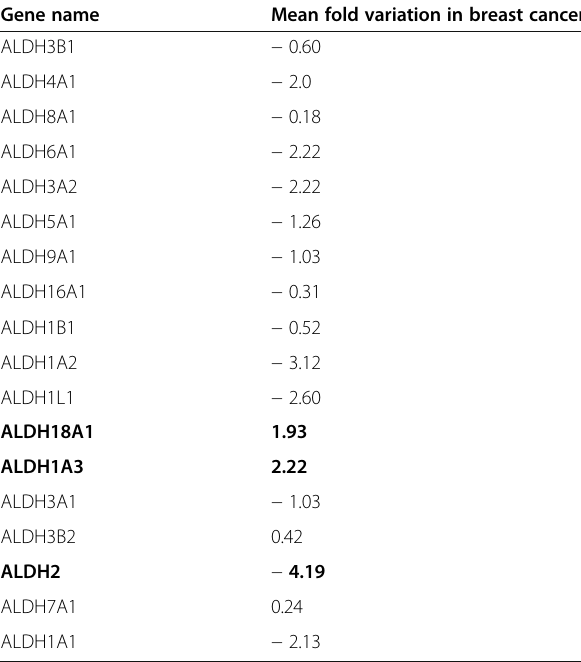
Table 3 Showing the list of fold variation in terms of gene expression profiling in ALDH isoforms